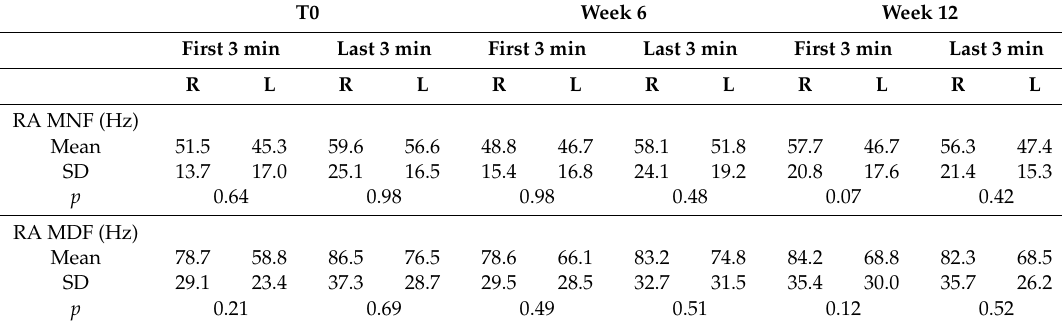
Table 7. Mean frequency (MNF) and median frequency (MDF) of RA muscle (in Hz) with respect to body side at each recording time (first 3 min and last 3 min of the session) and treatment time (T0: first session; 6w: week 6; 12w: week 12). Tukey multiple-comparison post-test p -values are